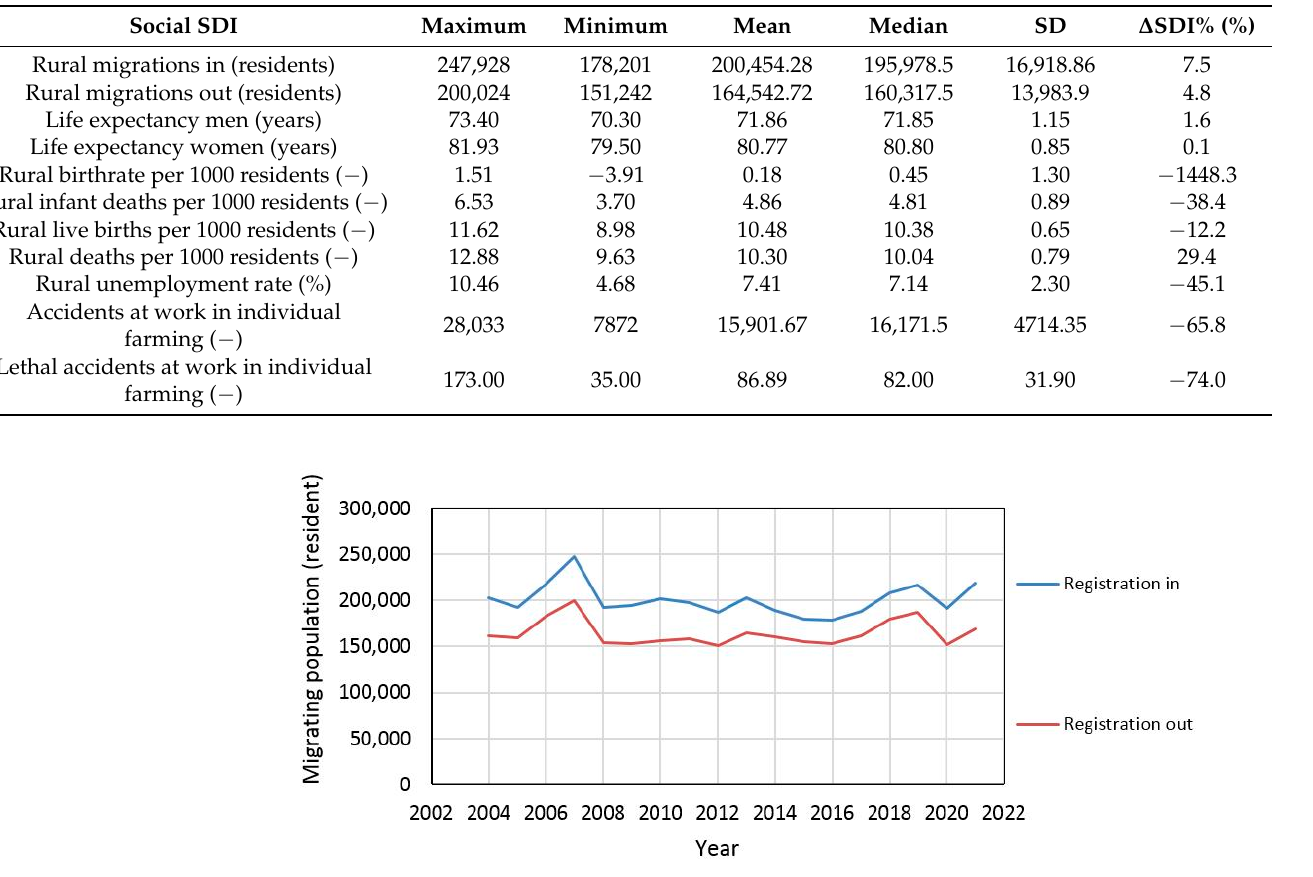
Figure 14. Life expectancy for urban and rural populations in Poland, age class less than 1 year, data obtained from [66]. Figure 15 shows population dynamics, i.e., live births and deaths, for 1000 rural and urban residents combined with the birthrate for 1000 residents. During the studied pe- riod, the number of live births was higher in the rural population than in urban. Since 2014, the death rate was also lower for rural populations. However, since 2017, a decrease in live births for both studied regions occurred. Moreover, it is visible that since the out- break of the COVID-19 SARS-Cov-2 pandemic, the number of registered deaths signifi- cantly increased, especially in the denser populated cities, from 10.92 deaths per 1000 residents in 2019 to 14.21 deaths per 1000 residents in 2021. The above observations are